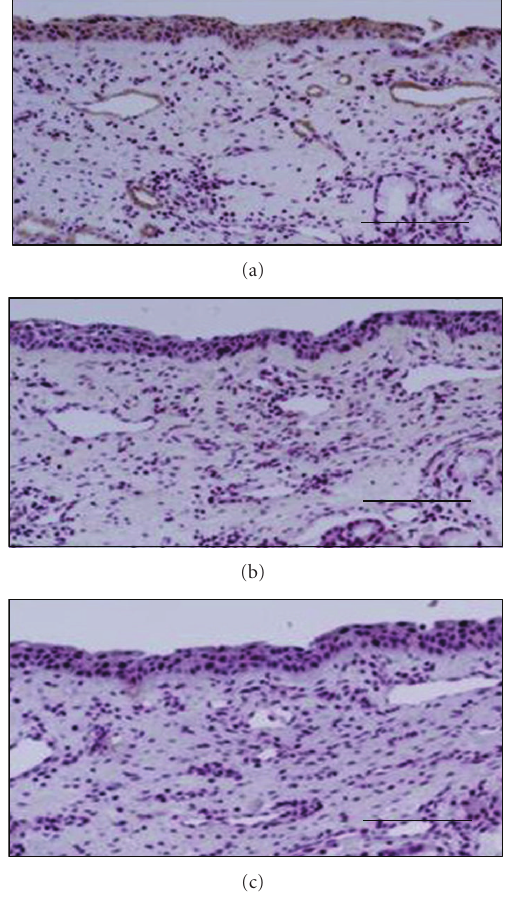
Figure 4: Immunohistochemical localization of histamine H1 receptor on human nasal mucosa. Inferior turbinates were stained with anti-human H1 receptor antibody (a, b) or normal rabbit immunoglobulin (c). The intensity of the H1 receptor staining was decreased by coincubation with a specific blocking peptide (b). Scale bar = 100 μ m.